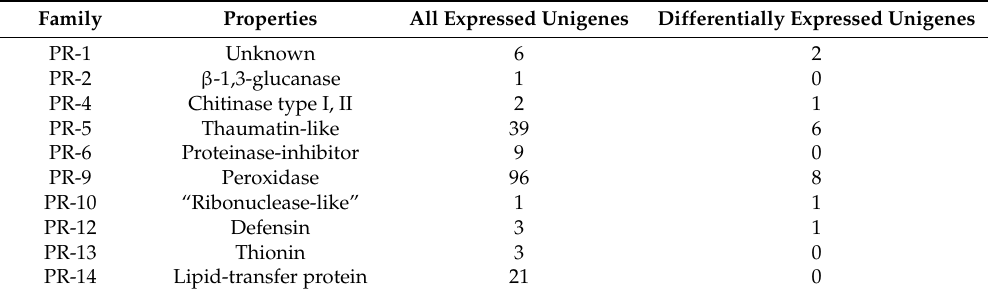
Table 4. Differentially expressed genes encoding pathogenesis-related